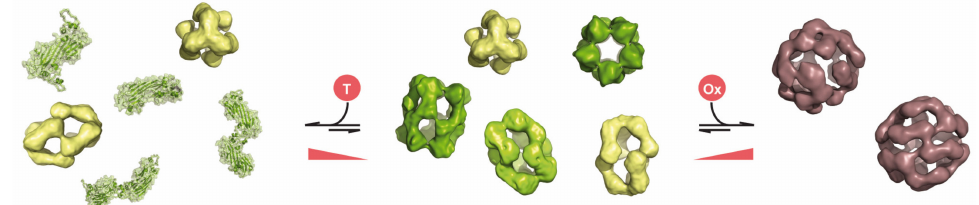
Figure 4. Scheme of α A activation at physiological conditions α A consists of an ensemble of oligomers where 12–20 mers are predominant (middle panel) [79]. Stress conditions like increased temperature (T) presumably lead to a shift of the ensemble composition to a smaller species [138,152,183,189]. Most likely tetrameric and dimeric building blocks dissociate from the oligomers which leads to an increase in the chaperone activity of α A (left panel). Oxidative stress (Ox; or more generally redox-stress)